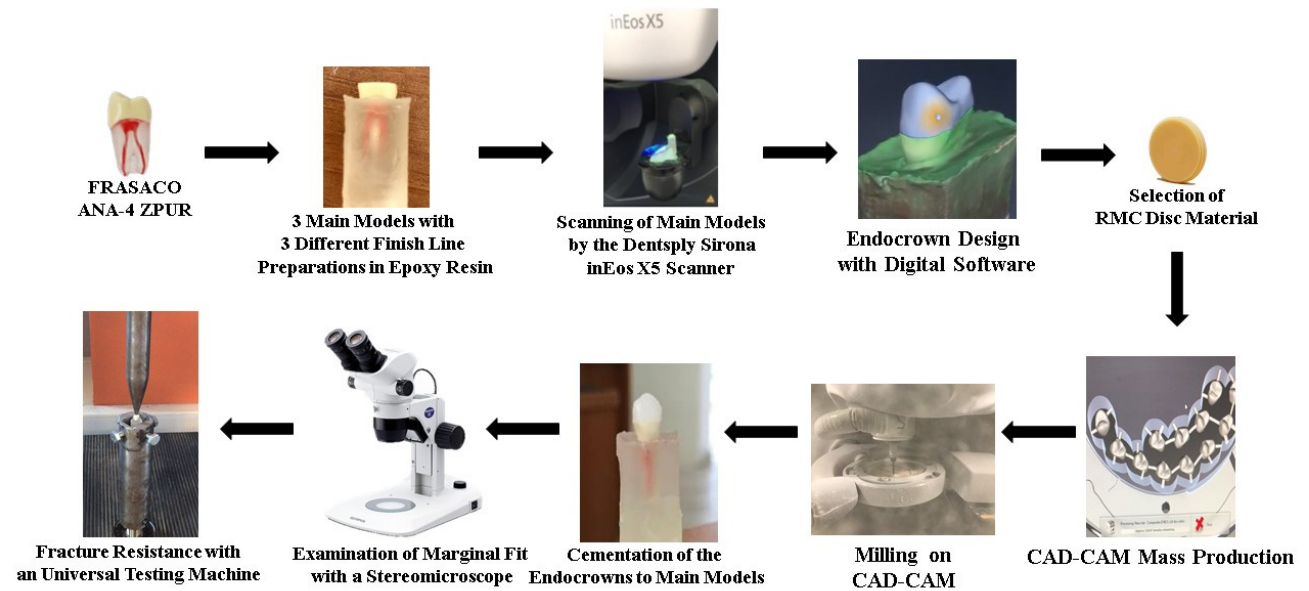
Figure 1. A schematic illustration of endo-crown preparation and study design. Table 1. Margin design, product, shapes, shades, ref, lot numbers and the composition of the CAD-CAM materials used in this